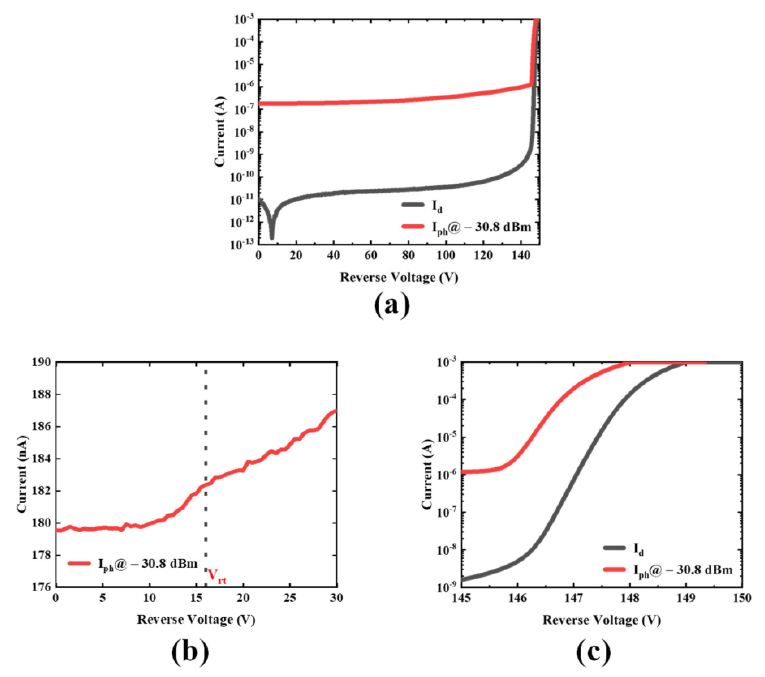
Figure 3. Current versus reverse voltage of the device: ( a ) the current versus reverse voltage from 0 V to 150 V; ( b ) the photocurrent under low bias voltage; ( c ) the dark current and photocurrent near the breakdown